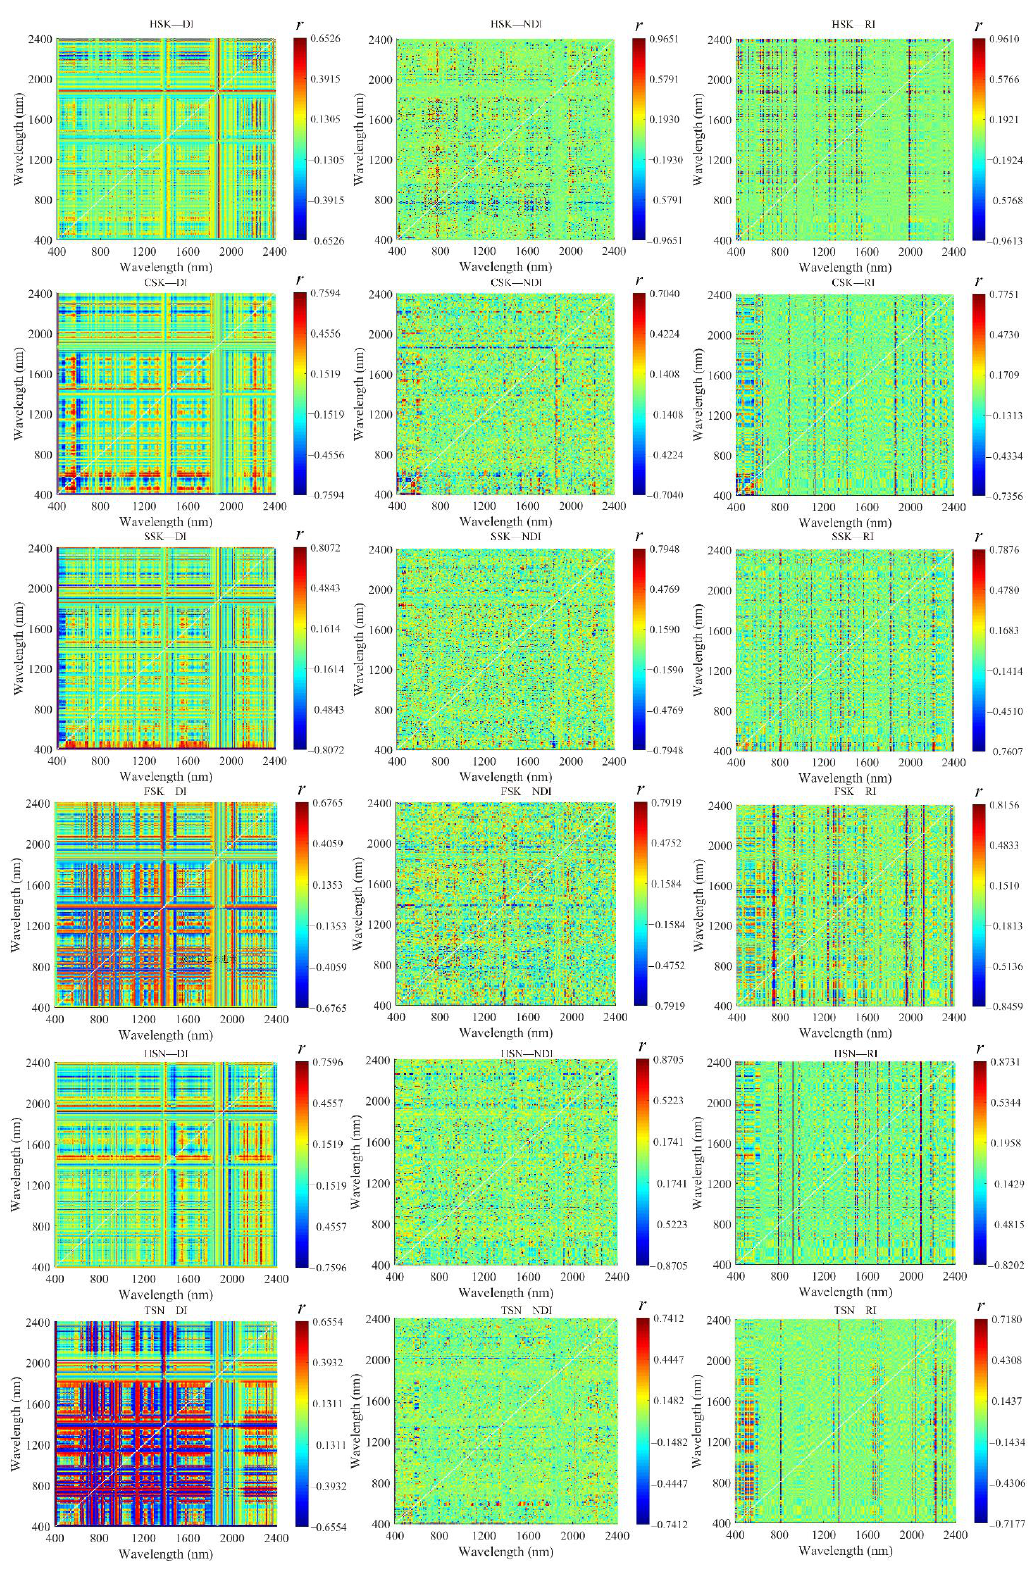
Figure 6. Two-dimensional correlation coefficients between the EC values and the salinity index under two derivative orders (The x and y axis represent the wavelength 400–2400 nm. The right-side color bar indicates the color of the PCC values. The colors dark red and dark blue represent a relatively high PCC (red for positive and blue for negative) between the measured EC and the band